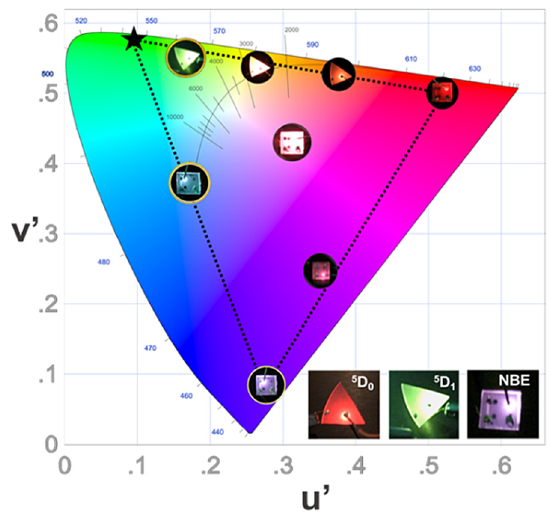
Figure 16: CIELUV plot containing various images of color-tunable Eu-doped GaN LEDs under different excitation and filtering condi- tions. The star indicates the maximum achievable pure green emission from the 5 D 1 state. The triangle containing the emission from the 5 D 0 state,thestar andthe Mg-Si defectindicates thegamut of colors that can be achieved by additively mixing the emission fromtheselevels.[Reprinted(adapted)withpermissionfromastudy by Mitchell et al. [22], Copyright 2019, American Chemical Society].